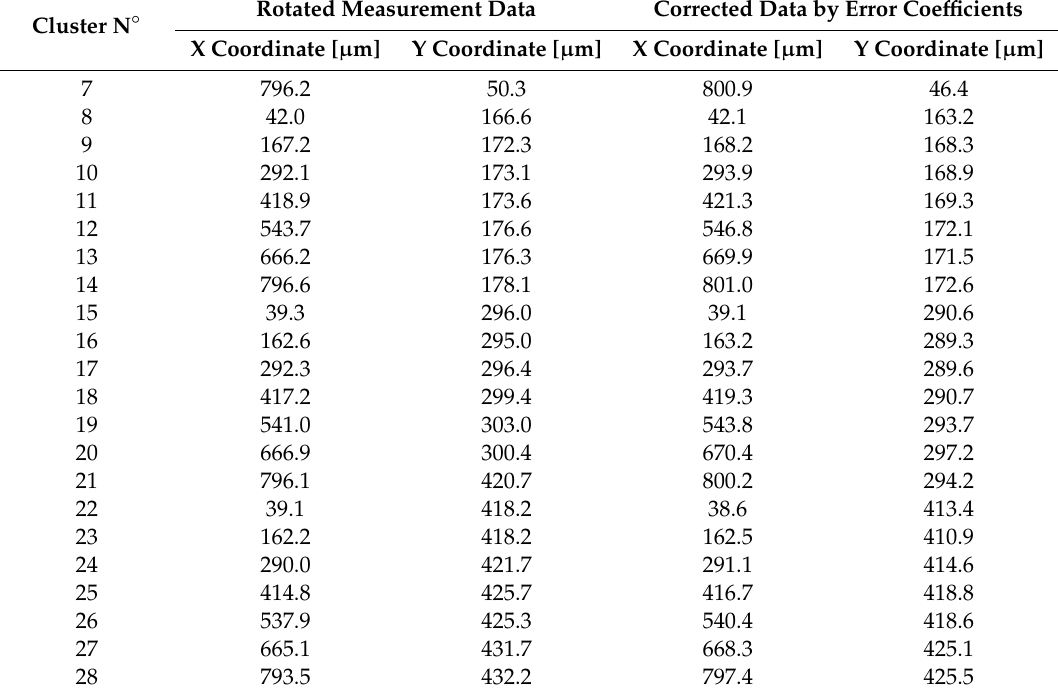
Table 6. Comparison of the certified, measured, and corrected positions. Cluster N ◦